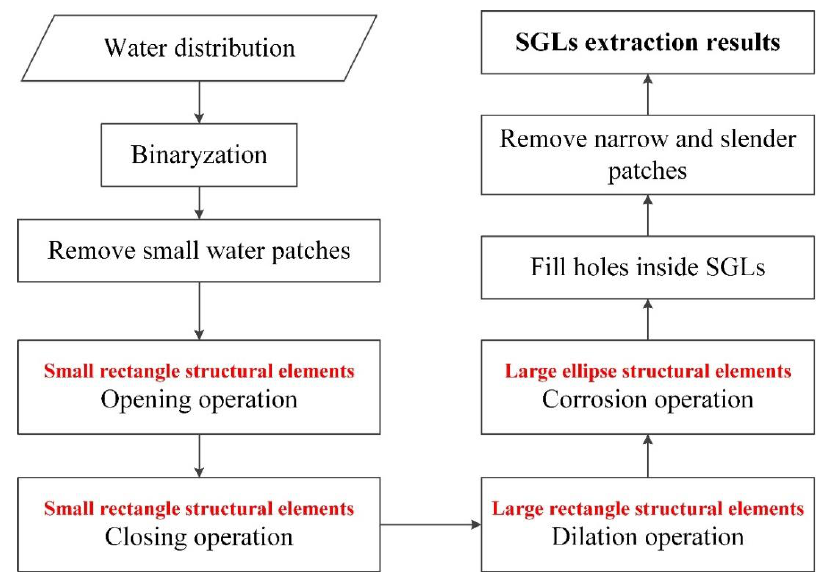
Figure 6. Flowchart designed to extract SGLs from water.